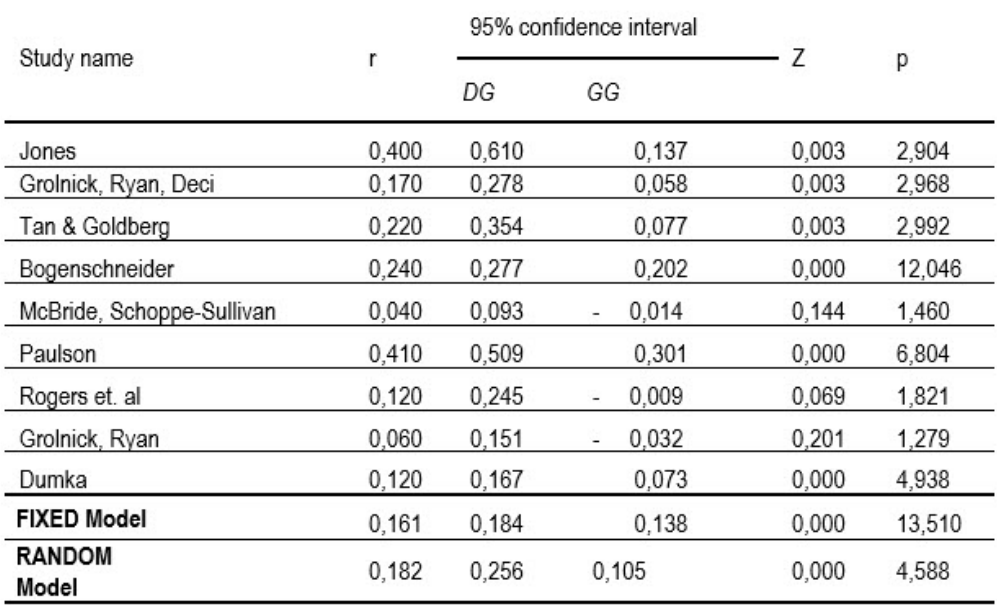
Meta-analysis: the correlation between fathers’ involvement and children’s academic